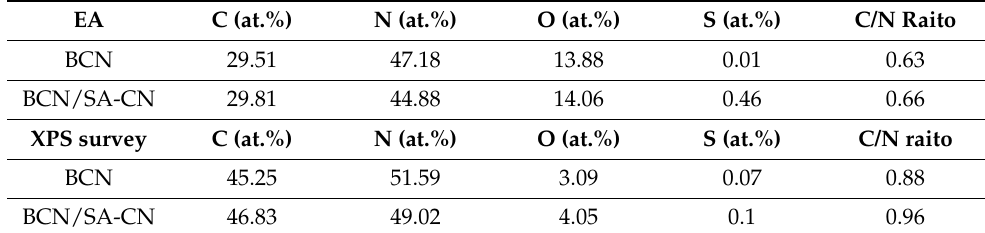
Figure 5. ( a ) FT-IR spectroscopy, ( b ) solid-state 13 C cross polarization-magic angle spinning (CP-MAS) NMR spectroscopy, ( c ) high-resolution C 1s, N 1s XPS, ( d ) powder XRD patterns, and ( e ) N 2 sorption isotherm of BCN and BCN/SA-CN. Inset of ( e ) is the pore size distribution of BCN and BCN/SA-CN calculated by the Barrett-Joyner-Halenda (BJH) method. Table 2. Atomic content of each element in BCN and BCN/SA-CN by EA and XPS survey scan.